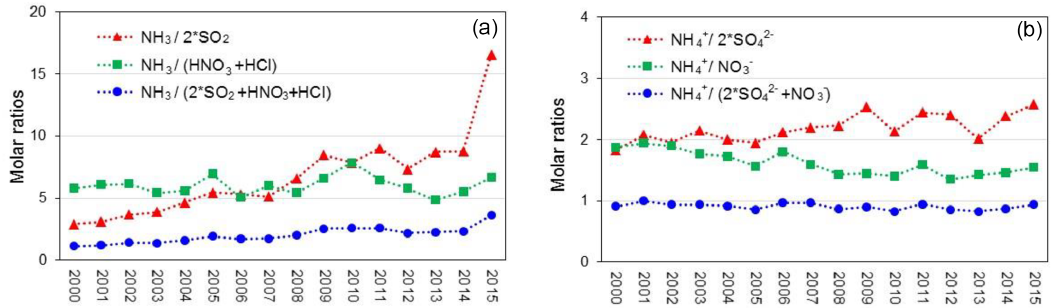
Figure 18. Long-term changes between 2000 and 2015 in (a) molar ratio of NH 3 to acid gases (SO 2 , HNO 3 , and HCl) and (b) molar ratio of particulate NH + to acid aerosols (SO 2 − and NO − ) from measurements made at 12 sites in 4 4 3